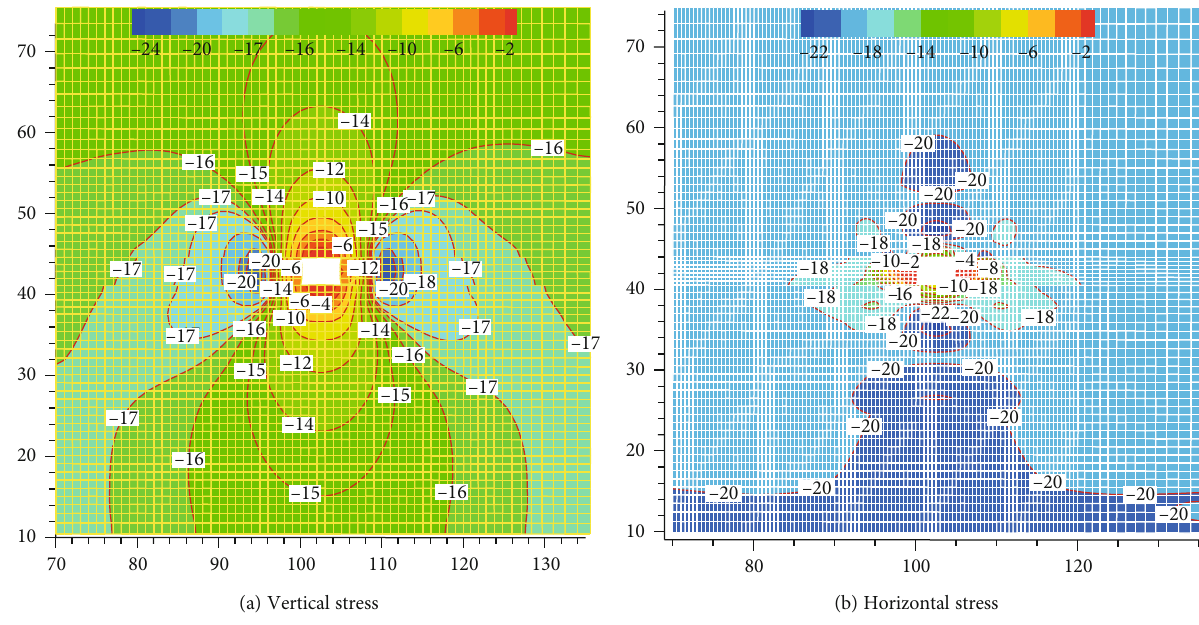
Figure 7: Distribution law of fl oor stress fi eld after roadway excavation. excavation, (2) 12050 working face transport roadway excavation, and (3) 12050 working face mining.